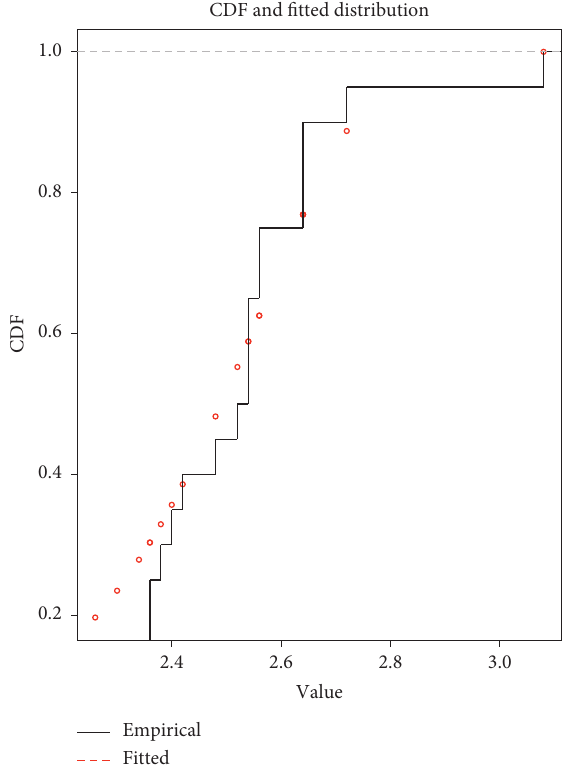
Figure 2: CDF of the data and hypothetical Gompertz distribution.